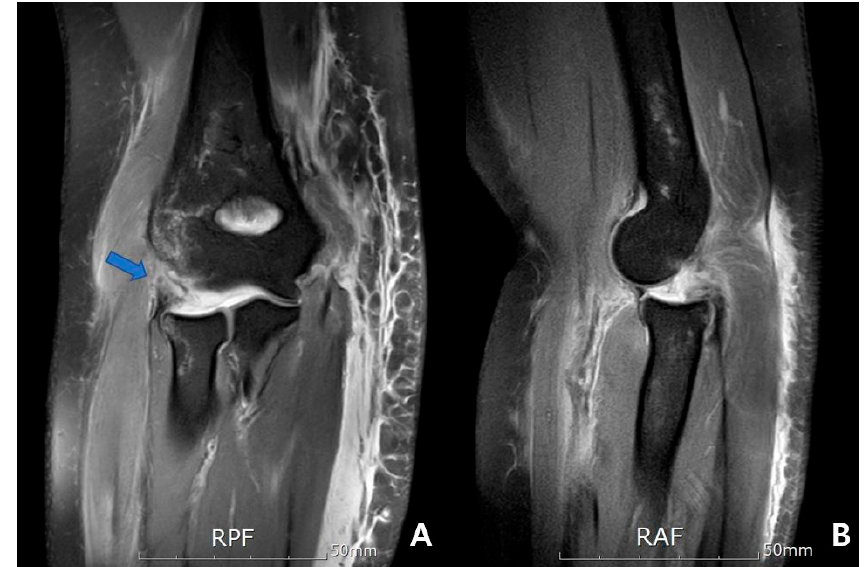
Figure 4. A 59-year old woman injured by a fall from height. Magnetic resonance images reveal stripping-type complete tears of the lateral collateral ligament and common extensor complex (arrow) ( A ) and a slightly posterior subluxated radial head ( B